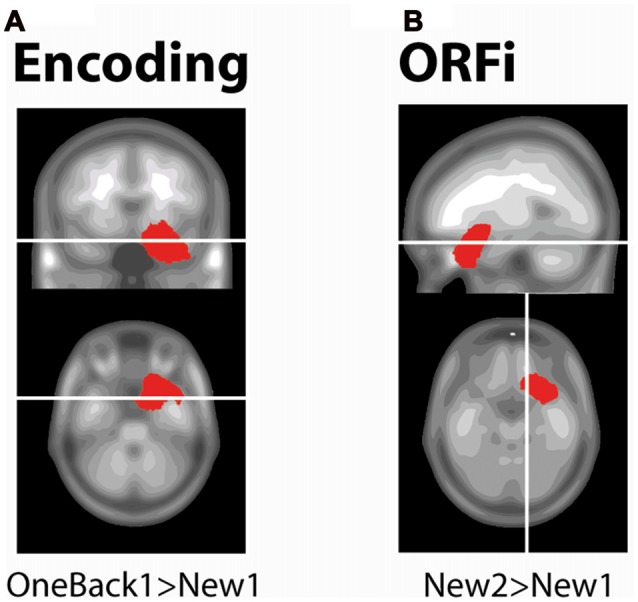
Source estimations. Estimated current densities differences between stimuli as determined with paired t-tests. White lines indicate the slices selected. Red areas depict solution points with statistically significant differences (p < 0.01 for ≥20 ms). (A) The encoding condition is exampled with statistical comparison of New1 and OneBack1. There is a stronger activation in the medial temporal lobe (MTL) in response to OneBack1 than New1 at 274 ms, which corresponds to the time of maximum ERP amplitude for OneBack1. (B) The ORFi condition is exampled with statistical comparison of New2 and New1. There is a stronger activation in the orbitofrontal cortex (OFC) in response to New2 than New1 at 308 ms, which corresponds to the time of maximum ERP amplitude for New2.